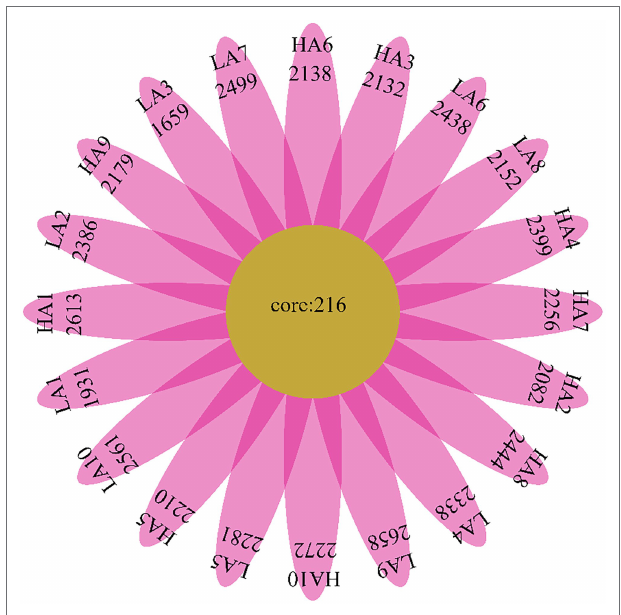
FIGURE 2 | Flower diagram plot of Sanhe heifer samples. The core community of all Sanhe heifers was defined as the operational taxonomic units present in all Sanhe heifers throughout the sampling period.